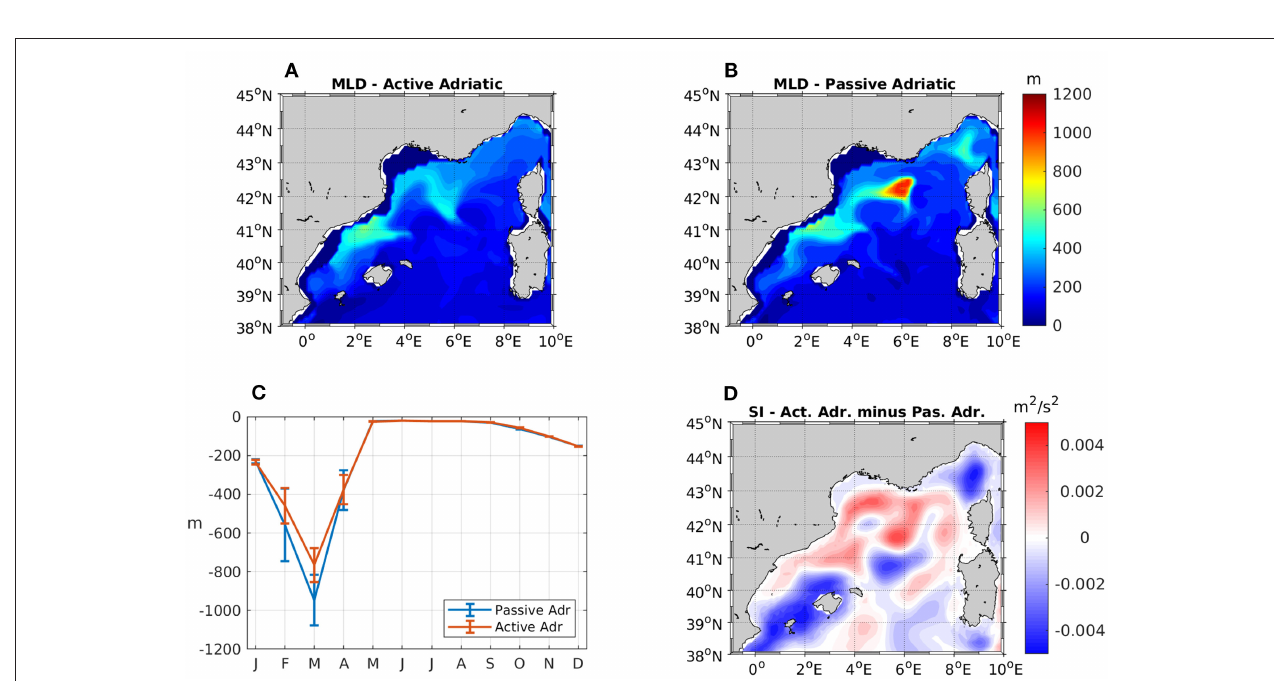
FIGURE 6 | A representative pattern of March MLD in active (A) and passive (B) Adriatic DWF states over the GoL region. Monthly mean of maximal MLD in the region depicted in the upper panels with standard deviation as error bars in both states (C) . Stratification Index difference between states (D) .